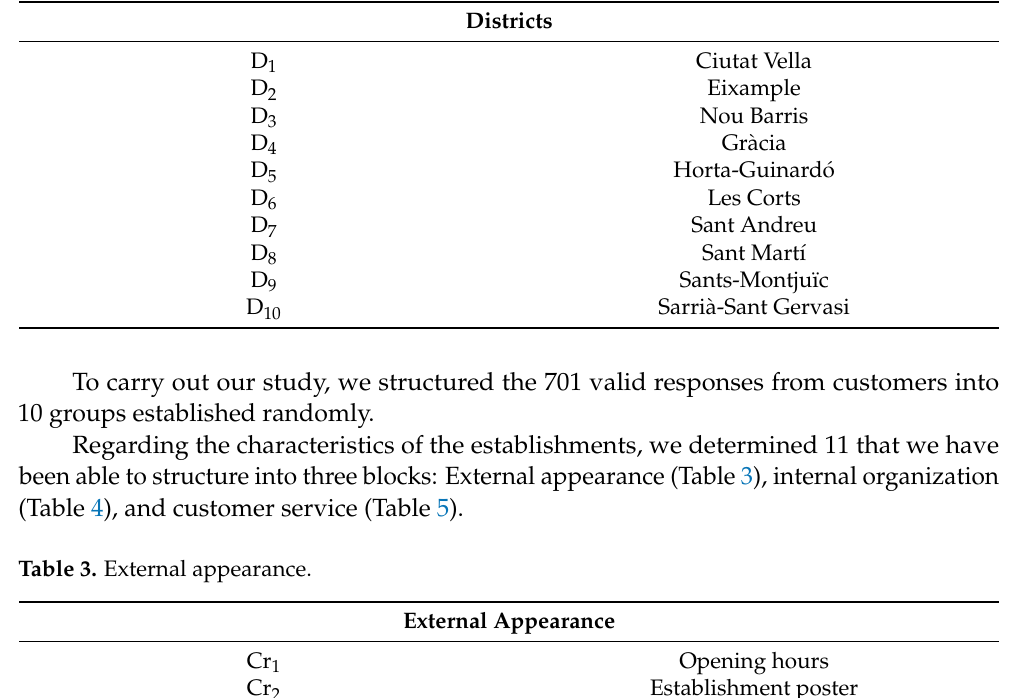
Table 2. Districts.